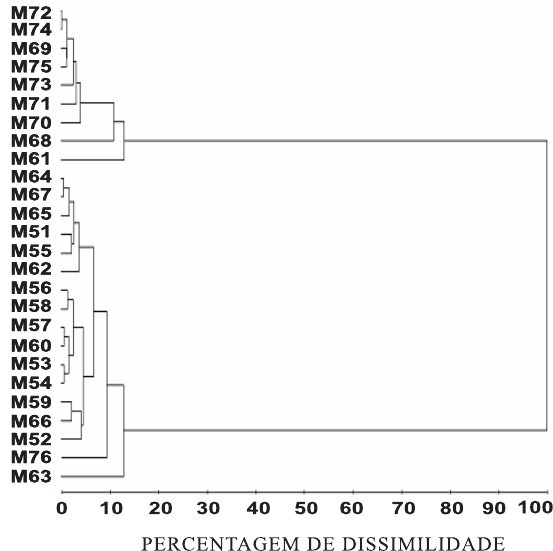
Figura 2. Dendrograma mostrando a percentagem de dissimilaridade entre 26 fungos micorrízicos isolados de quatro populações de Epidendrum secundum . O dendrograma foi obtido pela técnica UPGMA a partir da análise da matriz de distância de Mahalanobis. População I, isolados M51 a M60, população II, isolados M61 a M67, população III, isolados M68 a M76, e população IV, isolado